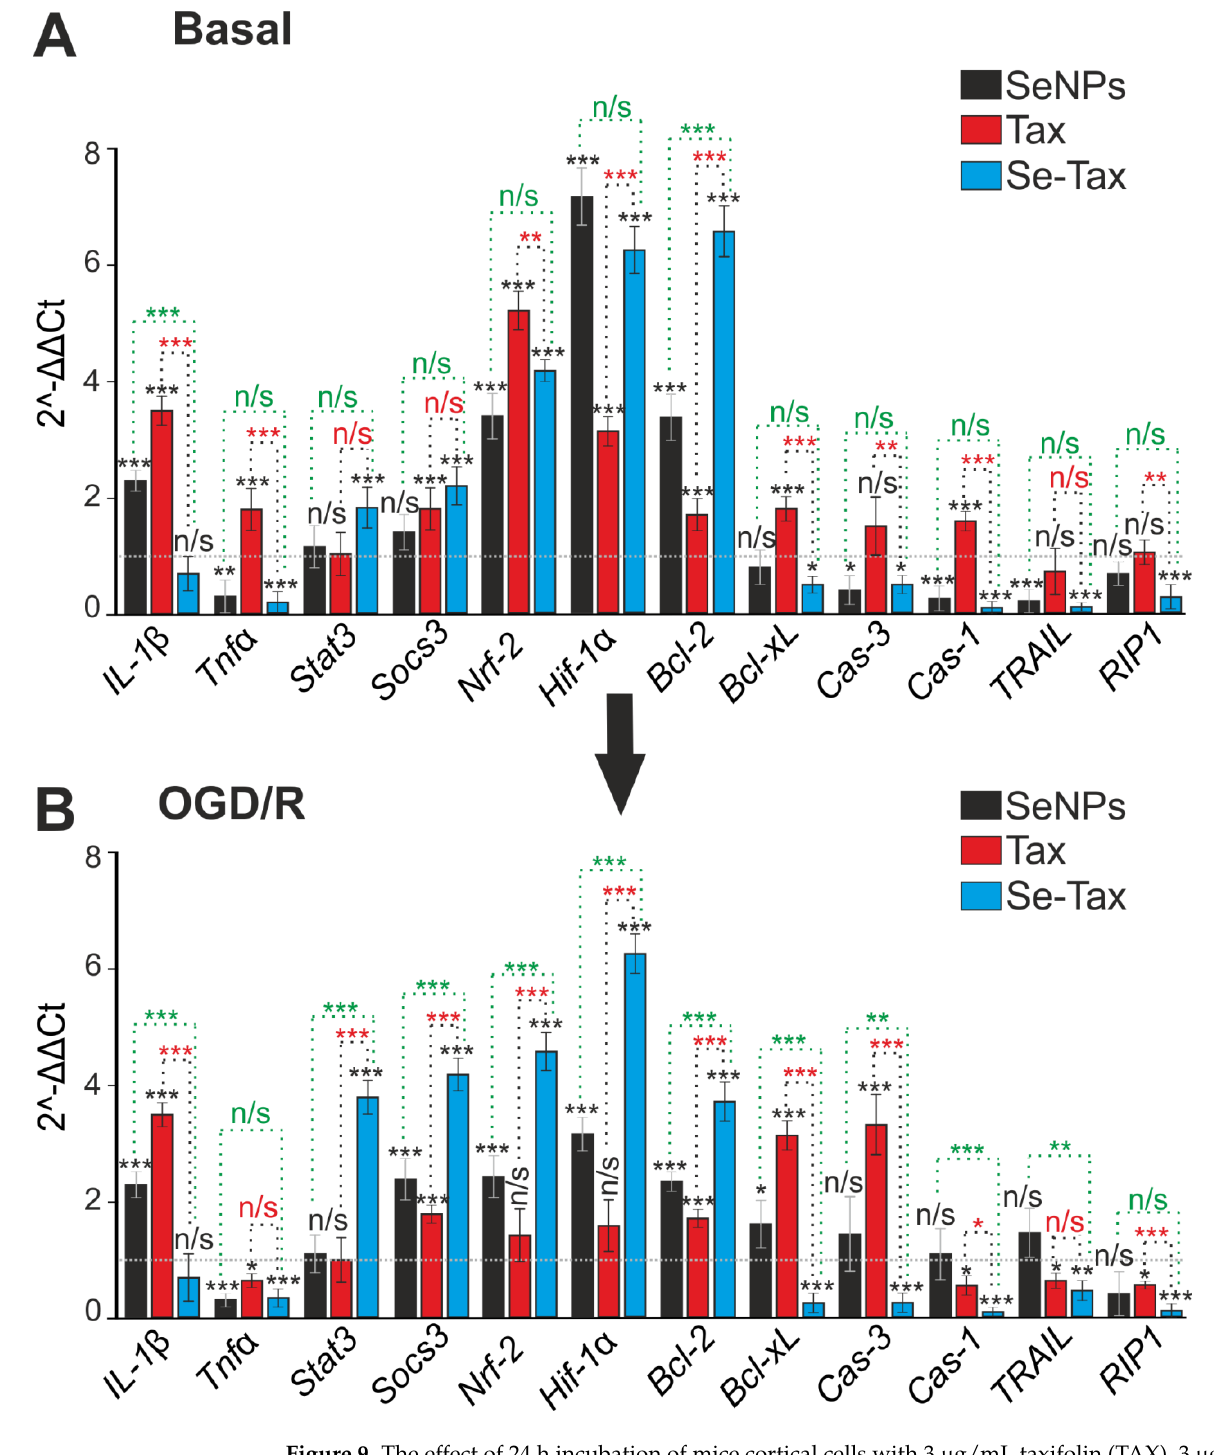
Figure 9. The effect of 24 h incubation of mice cortical cells with 3 µ g/mL taxifolin (TAX), 3 µ g/mL SeNPs, or 3 µ g/mL Se–TAX on the basal ( A ) and OGD/R-affected ( B ) expression of genes that regulate cell death and inflammation. Gene expression in control cells is marked with a dashed line for panel ( A ). Gene expression in OGD/R cells without treatment with test compounds are marked with a dashed line for panel ( B ). Statistical significance was assessed using t -test. Comparison of experimental groups with control: n/s—data not significant ( p > 0.05), * p < 0.05, ** p < 0.01, and *** p <0.001. Comparison of experimental groups with each other is indicated in red or green. The number of RNA samples is